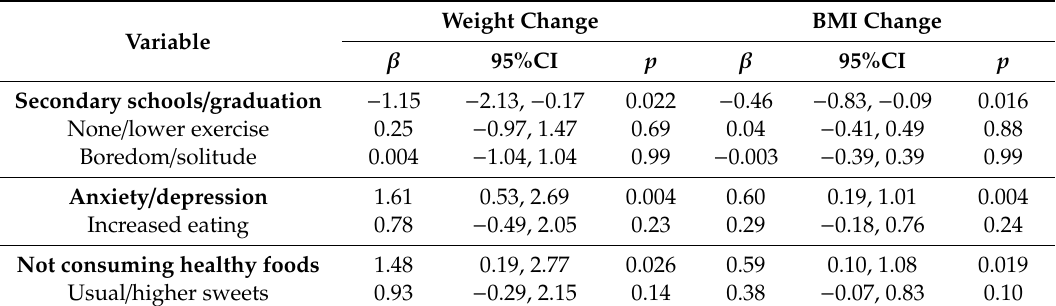
Table 4. Multiple regression analyses of the variables associated with weight and BMI changes during the lockdown